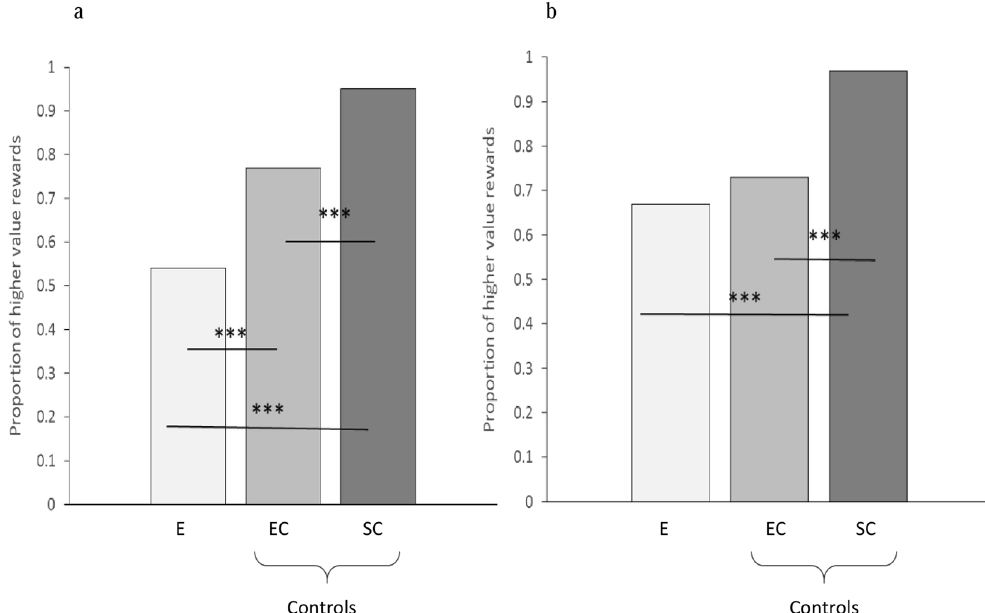
Figure 3. The proportion of higher value rewards selected by child B in the empty control, self-centered control, and experimental trials of the test (panel a) and retest (panel b) phases of the agent condition. Note. E = experimental trials, EC = empty control trials, SC = Self-centered control trials. *** p <